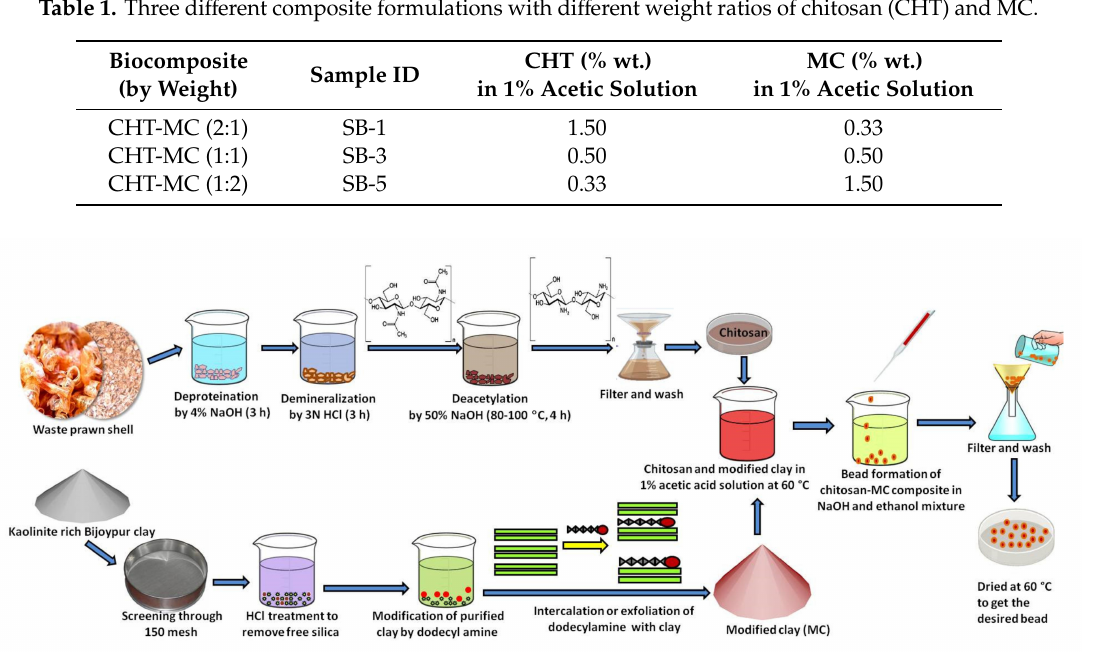
Figure 1. Schematic diagram of fabrication of chitosan-modified clay biocomposite